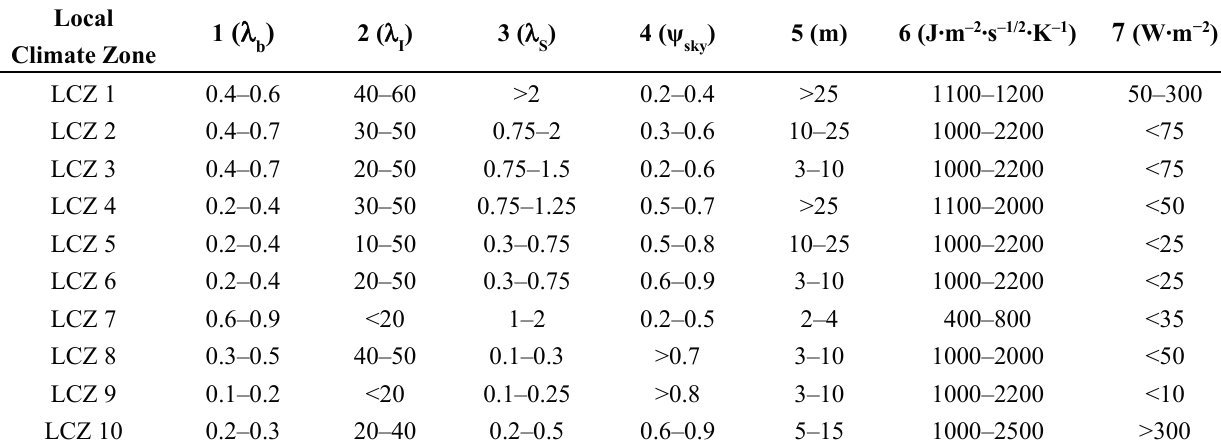
Table 1. Physical properties of the local climate zones, modified from [13], Tables 3 and 4. 1: Ratio of building plan area to total plan area (%); 2: Ratio of impervious plan area (paved, rock) to total plan area (%); 3: Mean height-to-width ratio of street canyons (LCZs 1–7), building spacing (LCZs 8–10), and tree spacing (LCZs A–G); 4: Ratio of the amount of